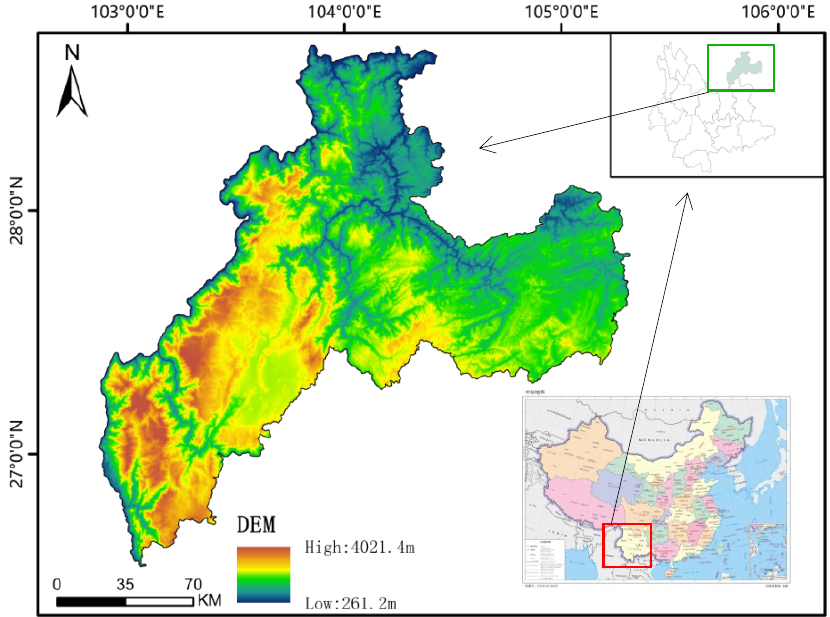
Figure 1. DEM data from the study area of Zhaotong City, Yunnan Province. The red frame shows the location of Yunnan Province in China, and the green frame shows the location of Zhaotong City in Yunnan Province.